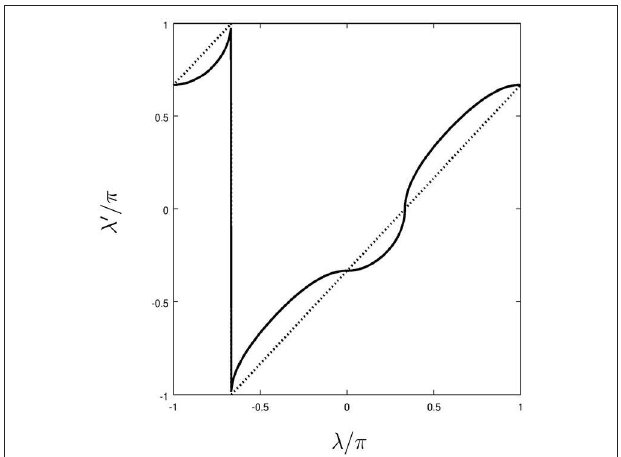
L ( λ λ ′ 1 ) for 1 π/ 3 (solid → = ; =